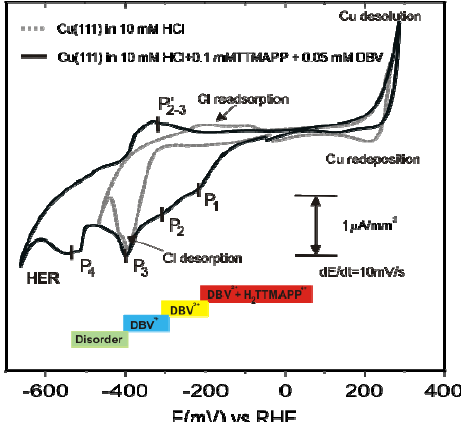
Figure 11. Cyclic voltammogram of a Cu(111) electrode in pure hydrochloric acid (dotted grey curve) and in an electrolyte containing a mixture of [H cations (black curve); the four cathodic peaks P the porphyrin- and the viologen-cations; scan rate d E /d t = 10 mV/s. The bars below the CVs indicate the existence regime of the respective ordered species or